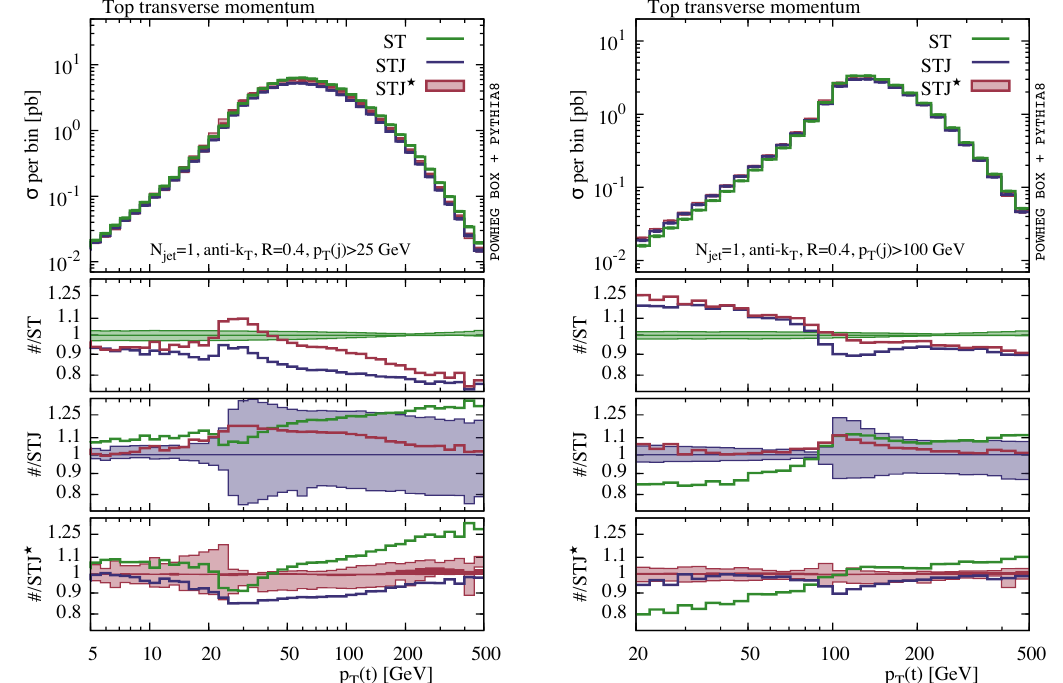
Figure 6 . Transverse momentum of the top quark in events containing exactly one light R = 0 : 4 anti- k t jet in addition to the top quark. On the left the distribution is de(cid:12)ned with a 25 GeV jet transverse momentum threshold, while on the right-hand side a 100 GeV threshold is used. No other cuts are applied. All predictions follow the same colour conventions as (cid:12)gures